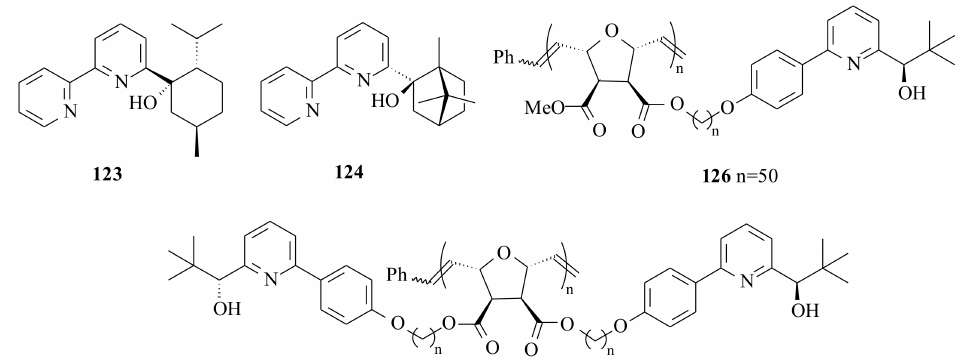
Figure 25. Bipyridyl and polymer-supported pyridyl alcohol ligand precursors.